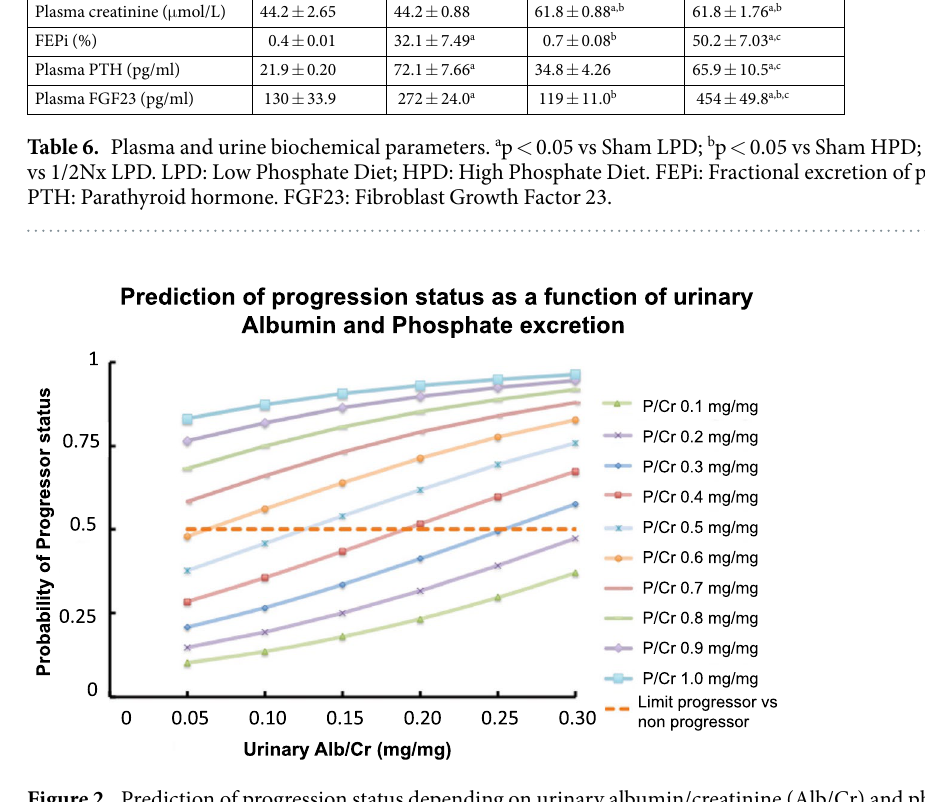
Figure 2. Prediction of progression status depending on urinary albumin/creatinine (Alb/Cr) and phosphate/ creatinine (P/Cr) (mg/mg). P = 1/(1 + EXP (2.093 − 4.197xP/Cr − 6.6xAlb/Cr).